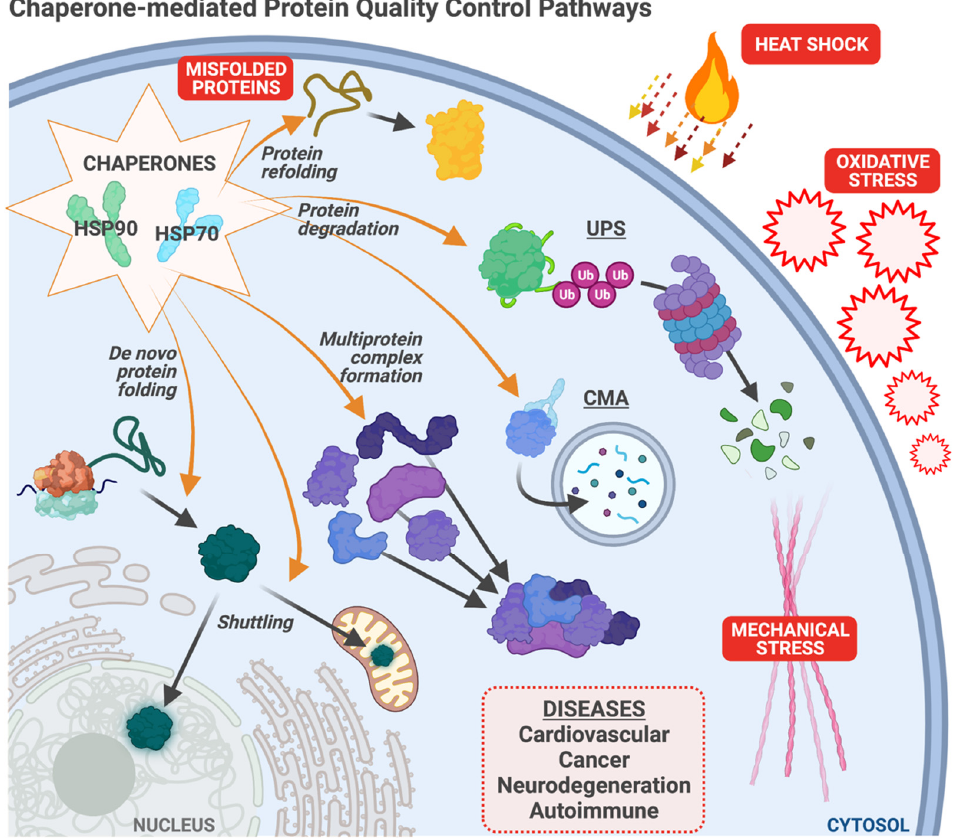
Figure 1. Chaperone-mediated protein quality control. Chaperones, including HSP70 and HSP90, maintain cellular homeostasis through multiple pathways: assisting with de novo protein folding; multiprotein complex formation; protein shuttling throughout the cell; degradation of terminally misfolded proteins (via the ubiquitin-proteasome system (UPS) and chaperone-mediated autophagy (CMA); and refolding of misfolded proteins damaged by cellular stress. The chaperone system responds to multiple stressors, including the accumulation of misfolded proteins, heat shock, oxidative stress, and mechanical stress. Chaperone dysfunction contributes to numerous diseases discussed in this review.